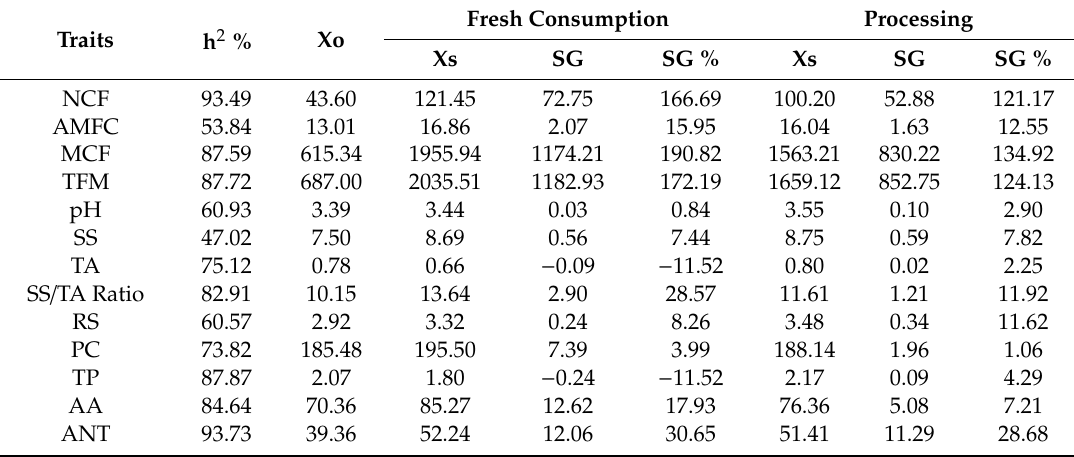
Table 2. Heritability estimation (h 2 ), mean of all hybrids (Xo), mean of selected clones (Xs), selection gain (SG), and percentage of selection gain (SG%) for traits analyzed in Fragaria × ananassa Duchesne ex Rozier hybrids obtained by the Mulamba and Mock [27] selection index, with economic weights determined for the selection for fruit production for fresh consumption and